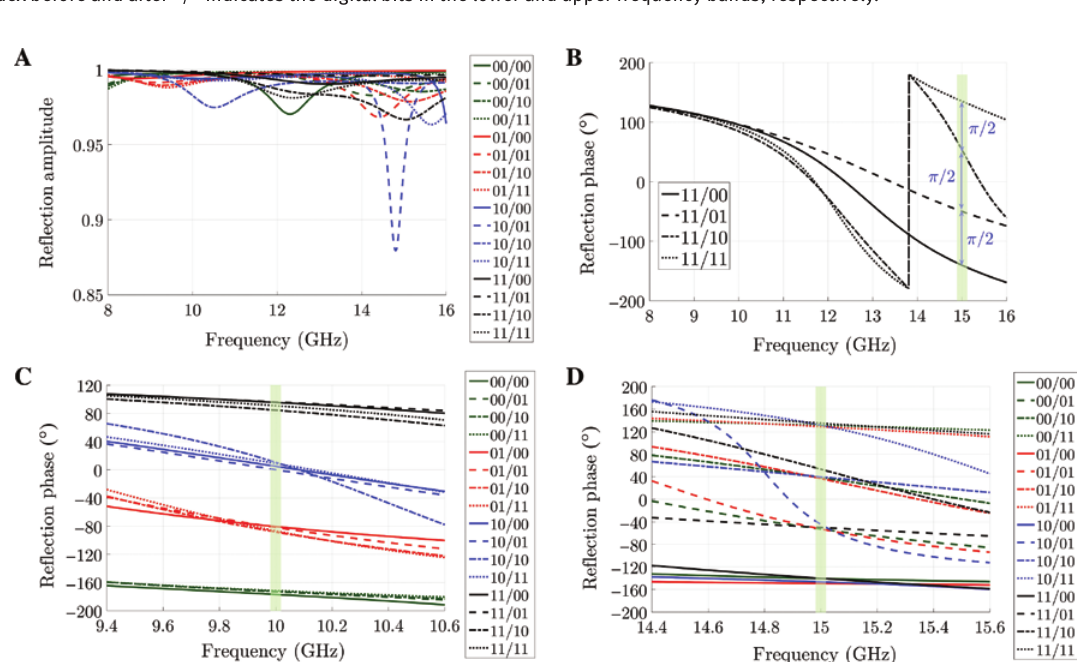
The index before and after “/” indicates the digital bits in the lower and upper frequency bands, respectively.